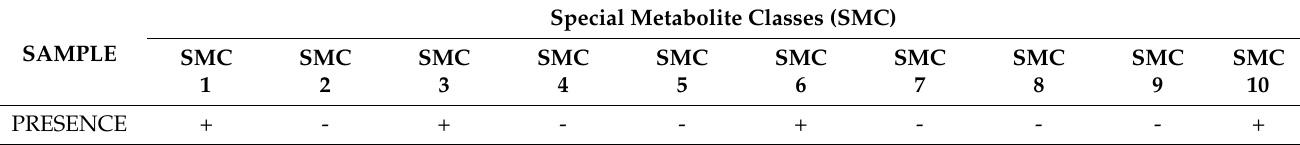
Table 1. Special metabolite classes identified in the aqueous extract of C. heliotropiifolius roots.